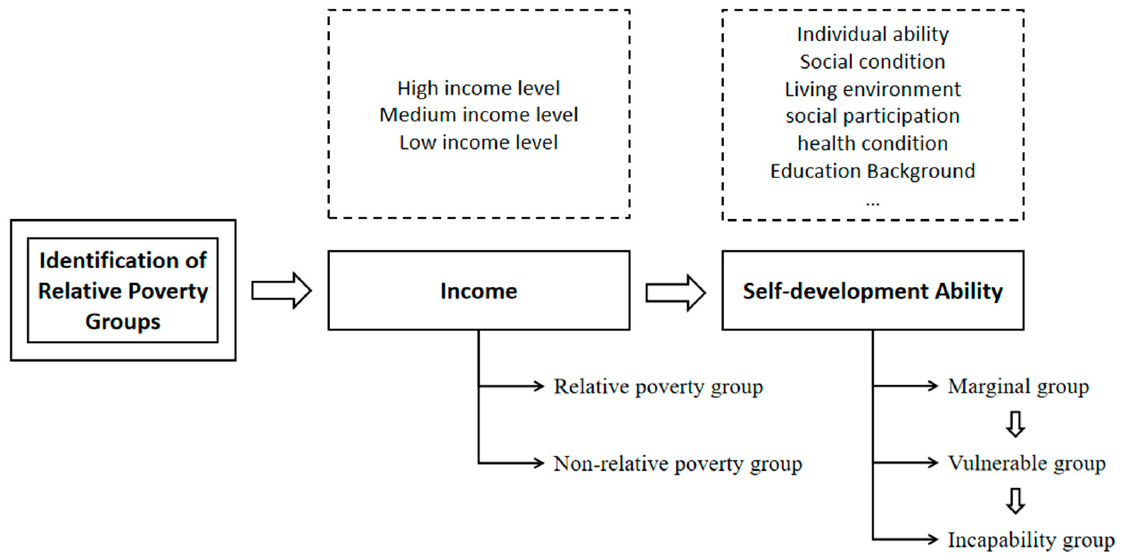
Figure 2. Identi fi cation of relative poverty groups. Figure 2. Identification of relative poverty